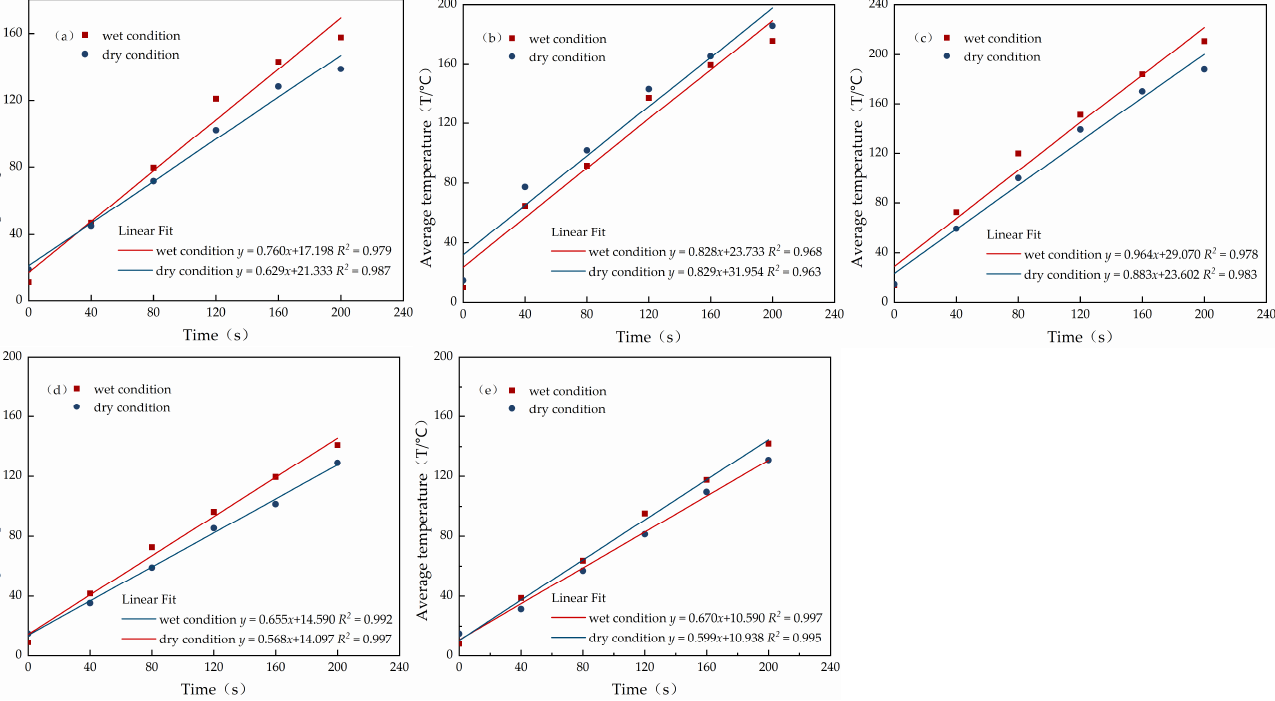
Figure 15. Fitted plots of average temperature of specimens of microwave-absorbing cement concrete made from different materials under dry and wet conditions: ( a ) magnetite; ( b ) iron sulfide slag; ( c ) steel slag; ( d ) lead–zinc slag; ( e ) graphite powder.